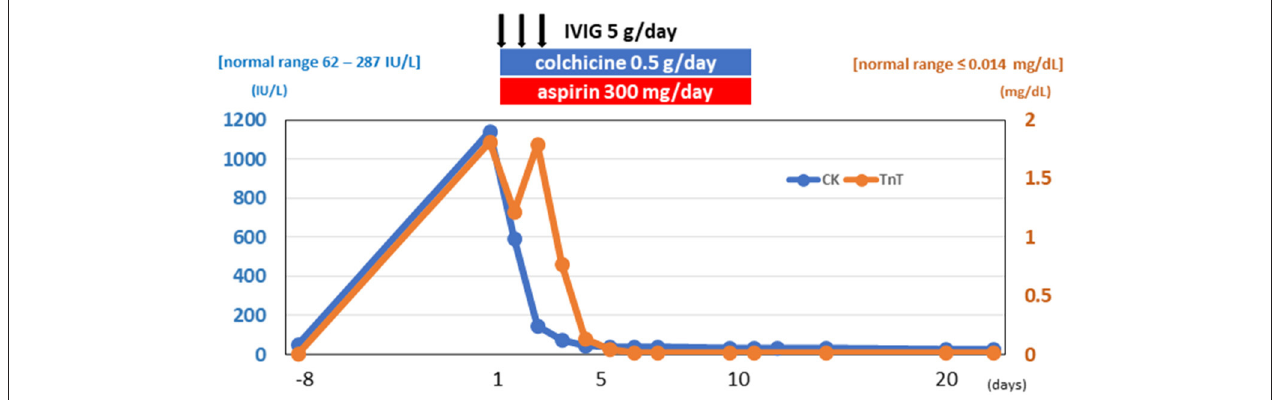
FIGURE 3 | Clinical course. Elevated cardiac enzymes decreased during his clinical course. CK, creatinine kinase; TnT, cardiac troponin T; IVIG, intravenous